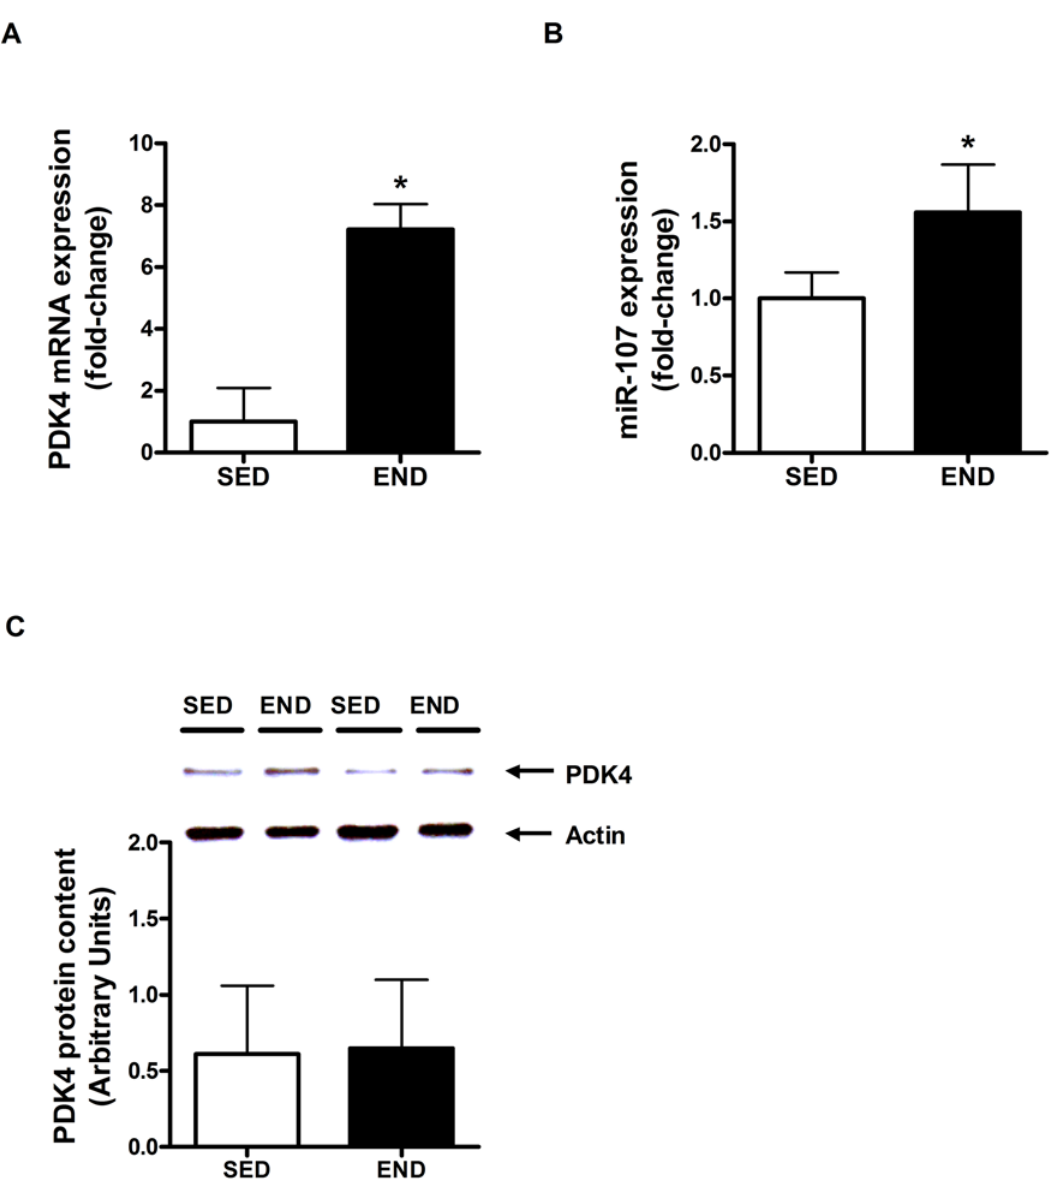
Figure 3. PDK4 content and miR-107 expression following exercise. (A) PDK4 mRNA expression and (B) protein content, and (C) miR-107 expression in the quadriceps of C57Bl/6J mice (N=7/group) 3-hour following an acute bout of END exercise vs. SED group. PDK4 mRNA expression, protein content and miR-107 expression are normalized to b -2 microglobulin, actin and Rnu6 , respectively. Asterisks denote significant changes (P #